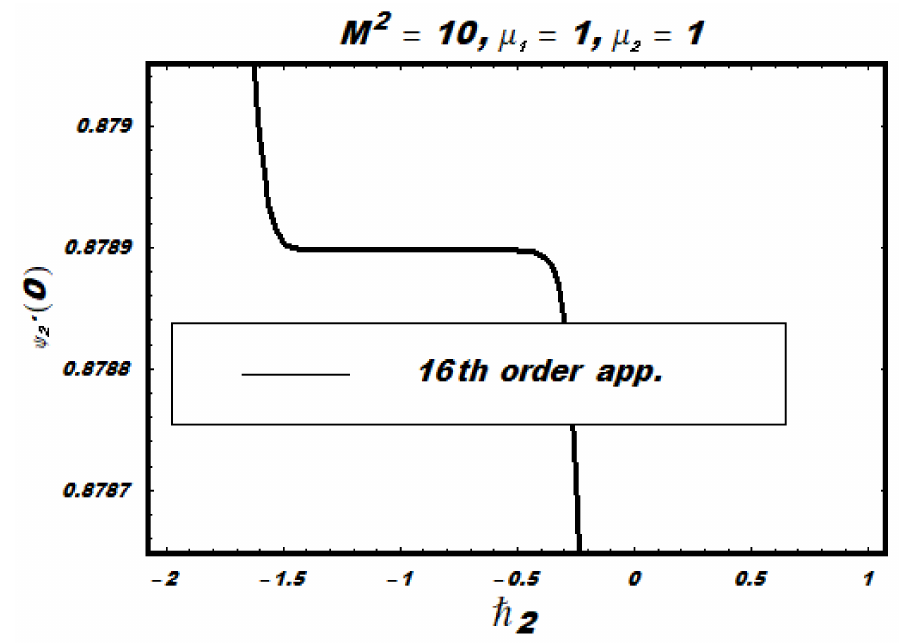
Figure 3. (cid:125) 2 for the strip / long slider.